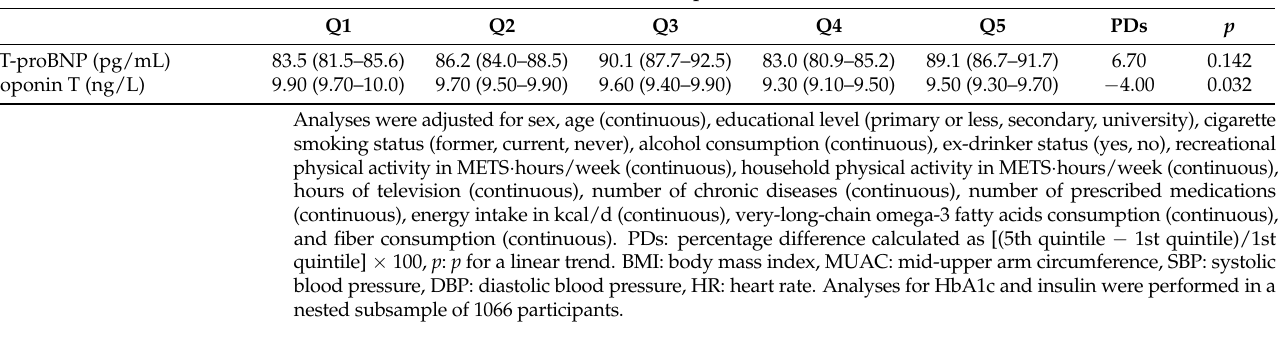
Table 4. Adjusted means (95% confidence interval), percentage difference, and p for a linear trend across quintiles of roasted food